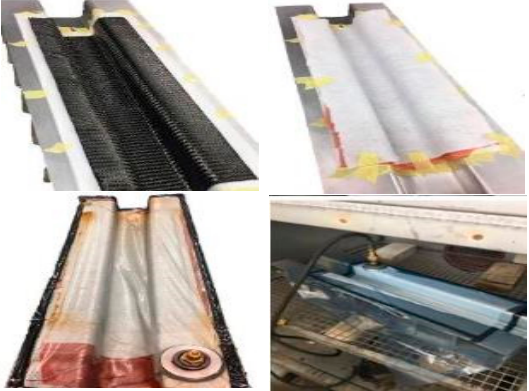
Figure 3. Composite manufacturing procedures. The top figures display the layup procedure, while the bottom figures display the vacuum bagging preparations.